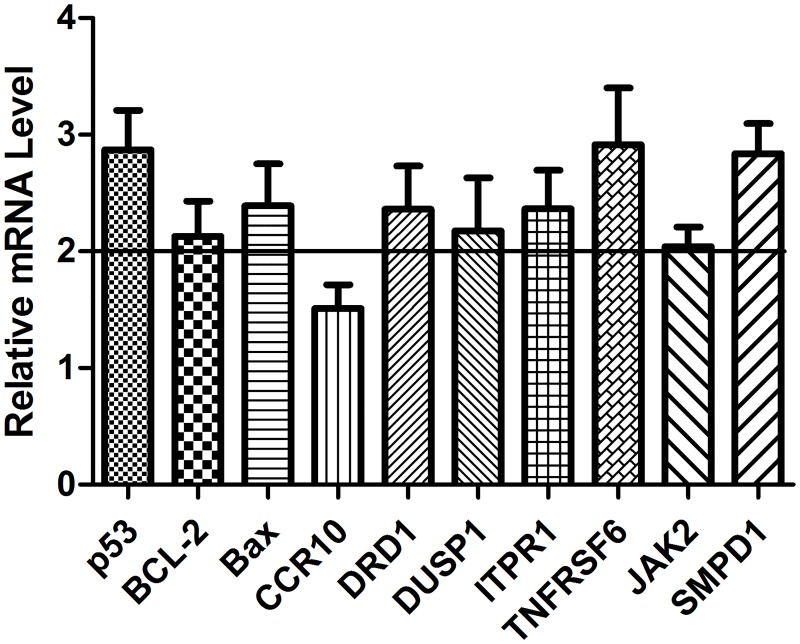
Differentially expressed gene detection resulting from rFIP-sch3 treatment.A549 cells were treated with 8 μg/mL rFIP-sch3 for 24 h. Relative mRNA levels of the ten genes (p53, BCL-2, Bax, CCR10, DRD1, DUSP1, ITPR1, TNFRSF6, JAK2 and SMPD1) were detected using qPCR, described as the means (error bars indicate SD) and represented as fold changes from controls.